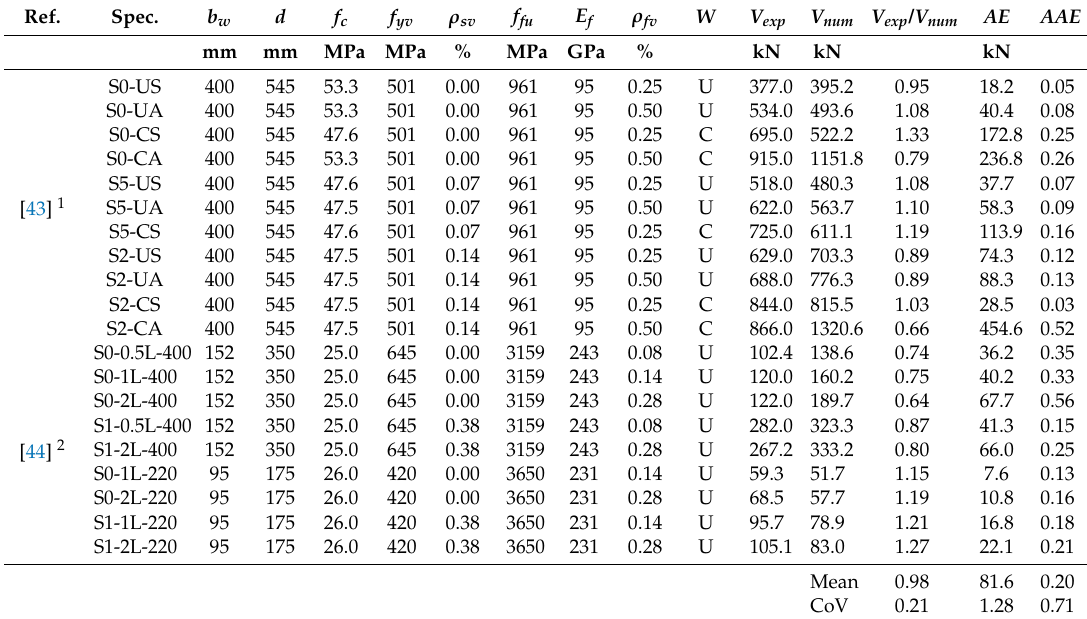
Table 1. Experimental and numerical ultimate shear of strengthened RC beams.